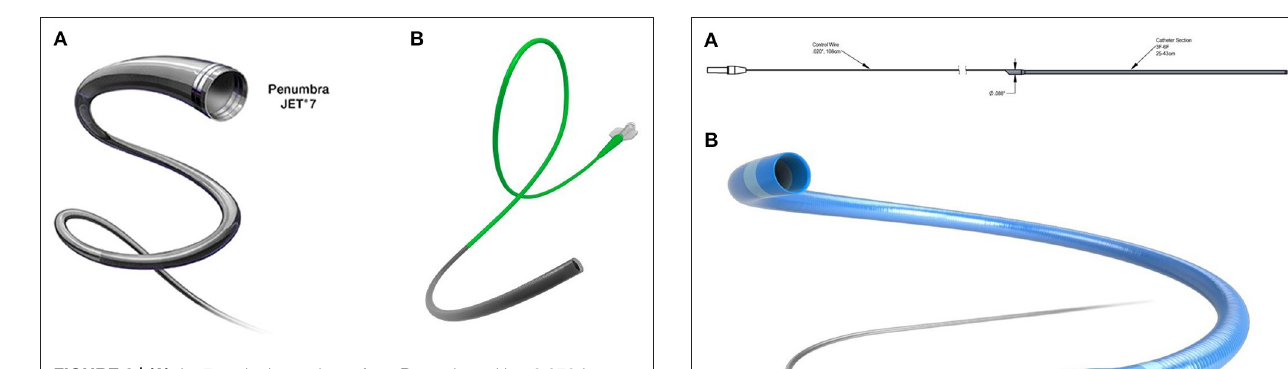
FIGURE 2 | (A) Jet 7 aspiration catheter from Penumbra with a 0.072-in (1.83mm) inner lumen for greater aspiration force. (B) React 71 aspiration catheter from Medtronic (Fridley, MN, USA) with an overlapping nitinol coil and braid design for better navigability and pushability.